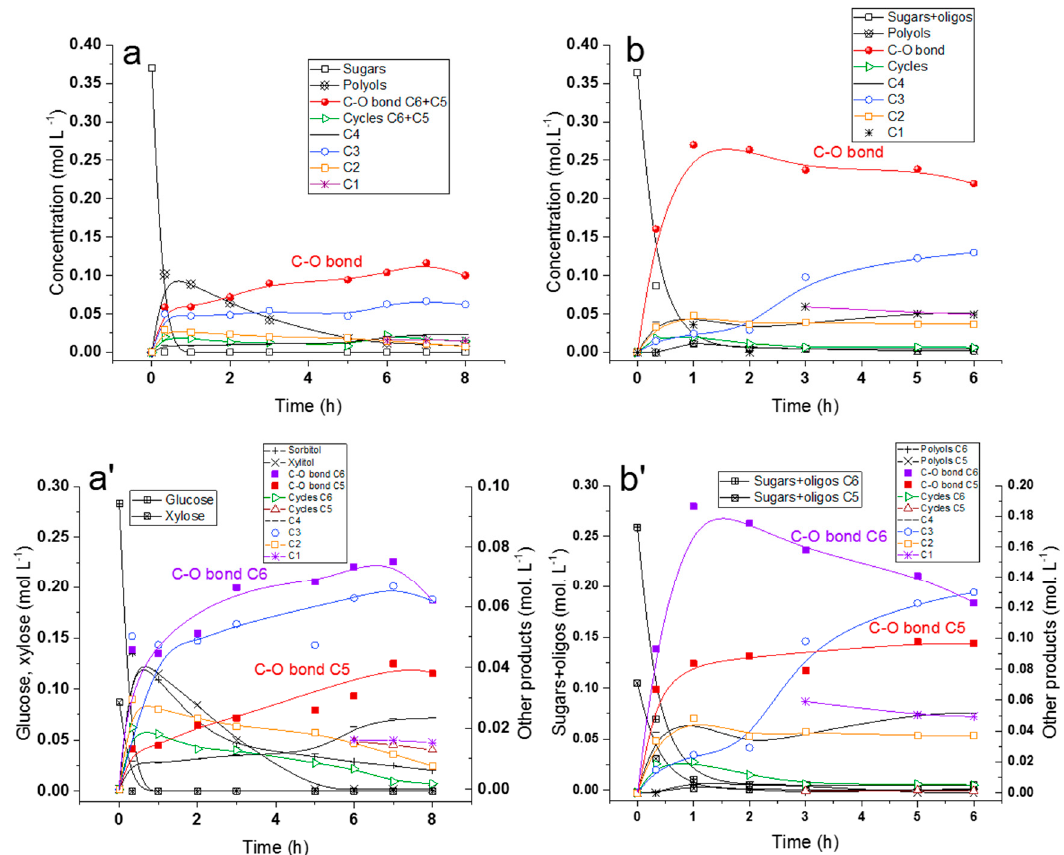
Figure 8. Evolution of families of products concentrations during hydrogenolysis of ( a , a’ ) glucose/xylose mixture (2/1) and of ( b , b’ ) hemicelluloses liquor over ReO x -Rh/ZrO 2 at 200 °C under 80 bar H 2 .